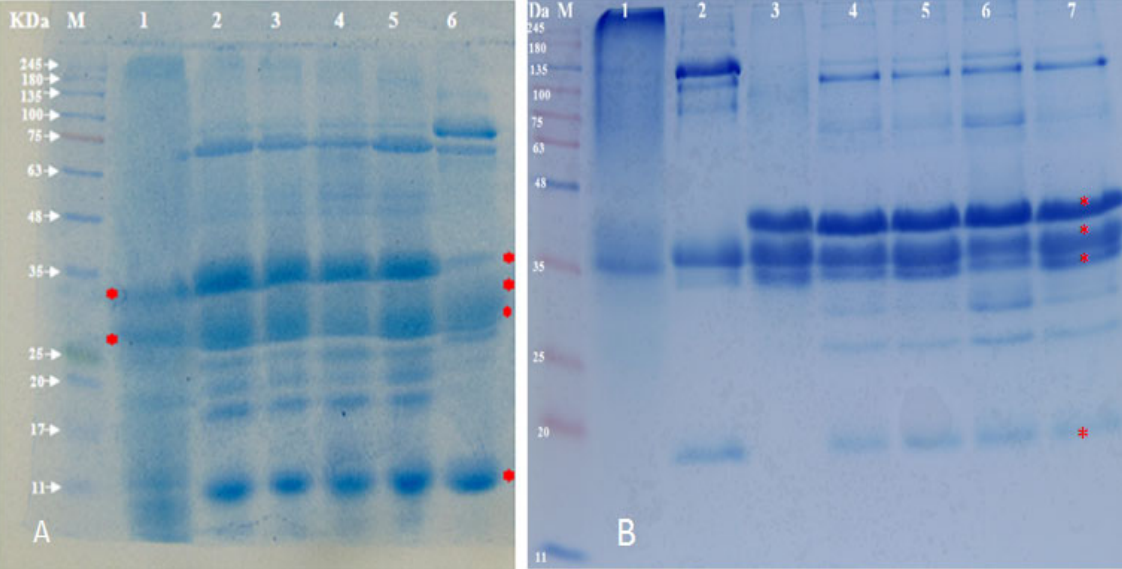
Figure 2. Analysis of milk proteins using 12.5% Sodium dodecyl sulfate-polyacrylamide gel elec- trophoresis ( A ) and Sodium dodecyl sulphate-Urea polyacrylamide gel electrophoresis ( B ). The panel A profile includes purified bovine casein (Sigma-Aldrich C-4765; Merck KGaA, Darmstadt, Germany) in lane 1, camel milk proteins from Wadha, Hamra, Safra, and Majahem clans (lanes 2, 3, 4, and 5, respectively), and human milk proteins in lane 6. Panel B includes purified bovine casein (Sigma-Aldrich C-4765) in lane 1 and human milk proteins in lane 2, and camel milk proteins from Wadha, Hamra, Safra, and Majahem clans (lanes 3, 4, 5, and 6, respectively), and lane 7 is the repeated analysis of Majahem milk. The leftmost lane in both panels shows the pre-stained molecular mass standard proteins. The red asterisks from up to down are pointed at the casein bands, then the camel and human α -lactalbumin